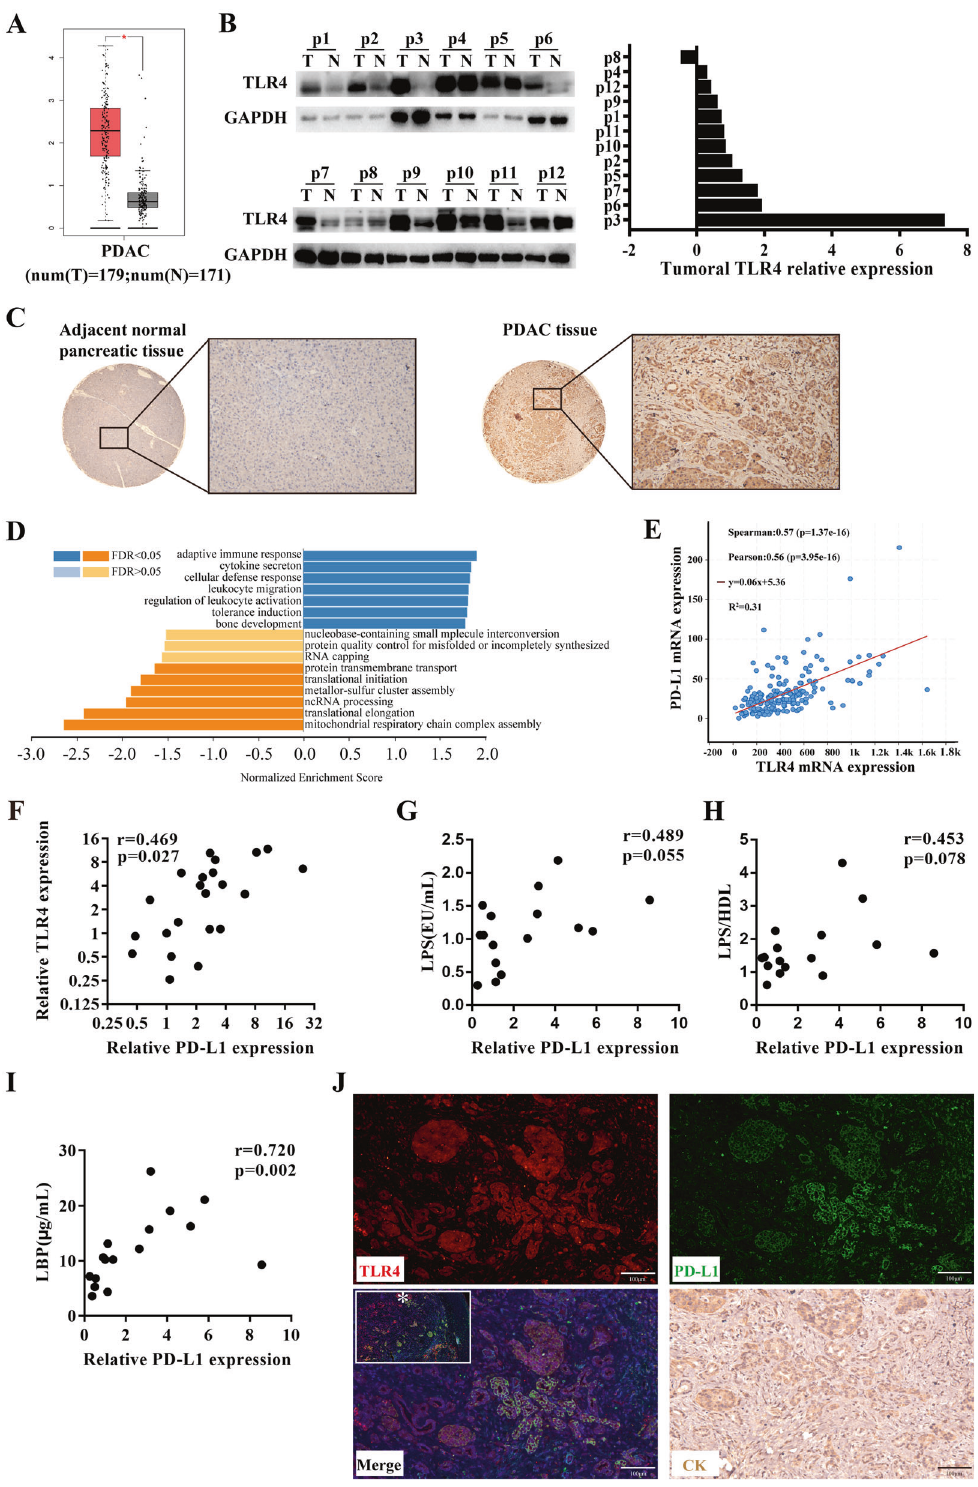
Fig. 3 TLR4 was overexpressed in pancreatic cancer and induced both immune in fi ltration and immunosuppressive molecular PD-L1 in pancreatic cancer. A GEPIA analyzed TLR4 transcription data in PDAC tissues and normal tissues from the TCGA database. B western blot measured TLR4 protein expression in PDAC tumor tissues and adjacent normal tissues. C representative image of TLR4 expression in adjacent normal tissues and PDAC tissues. D LinkedOmics analyzed signi fi cantly enriched GO_BP annotations by GSEA of TLR4 in PDAC. E cBioportal tools analyzed the correlation between TLR4 and PD-L1 transcription in PDAC. F qRT-PCR measured TLR4 and PD-L1 mRNA expression in pancreatic cancer tissues. PDAC patient Serum LPS ( G ), serum LBP ( H ), and LPS/HDL ( I ) had a positive correlation with tumoral PD-L1 transcription. J representative image of TLR4 and PD-L1 co-immuno fl uorescence in PDAC tissues slice and CK19 staining in a continuous slice.